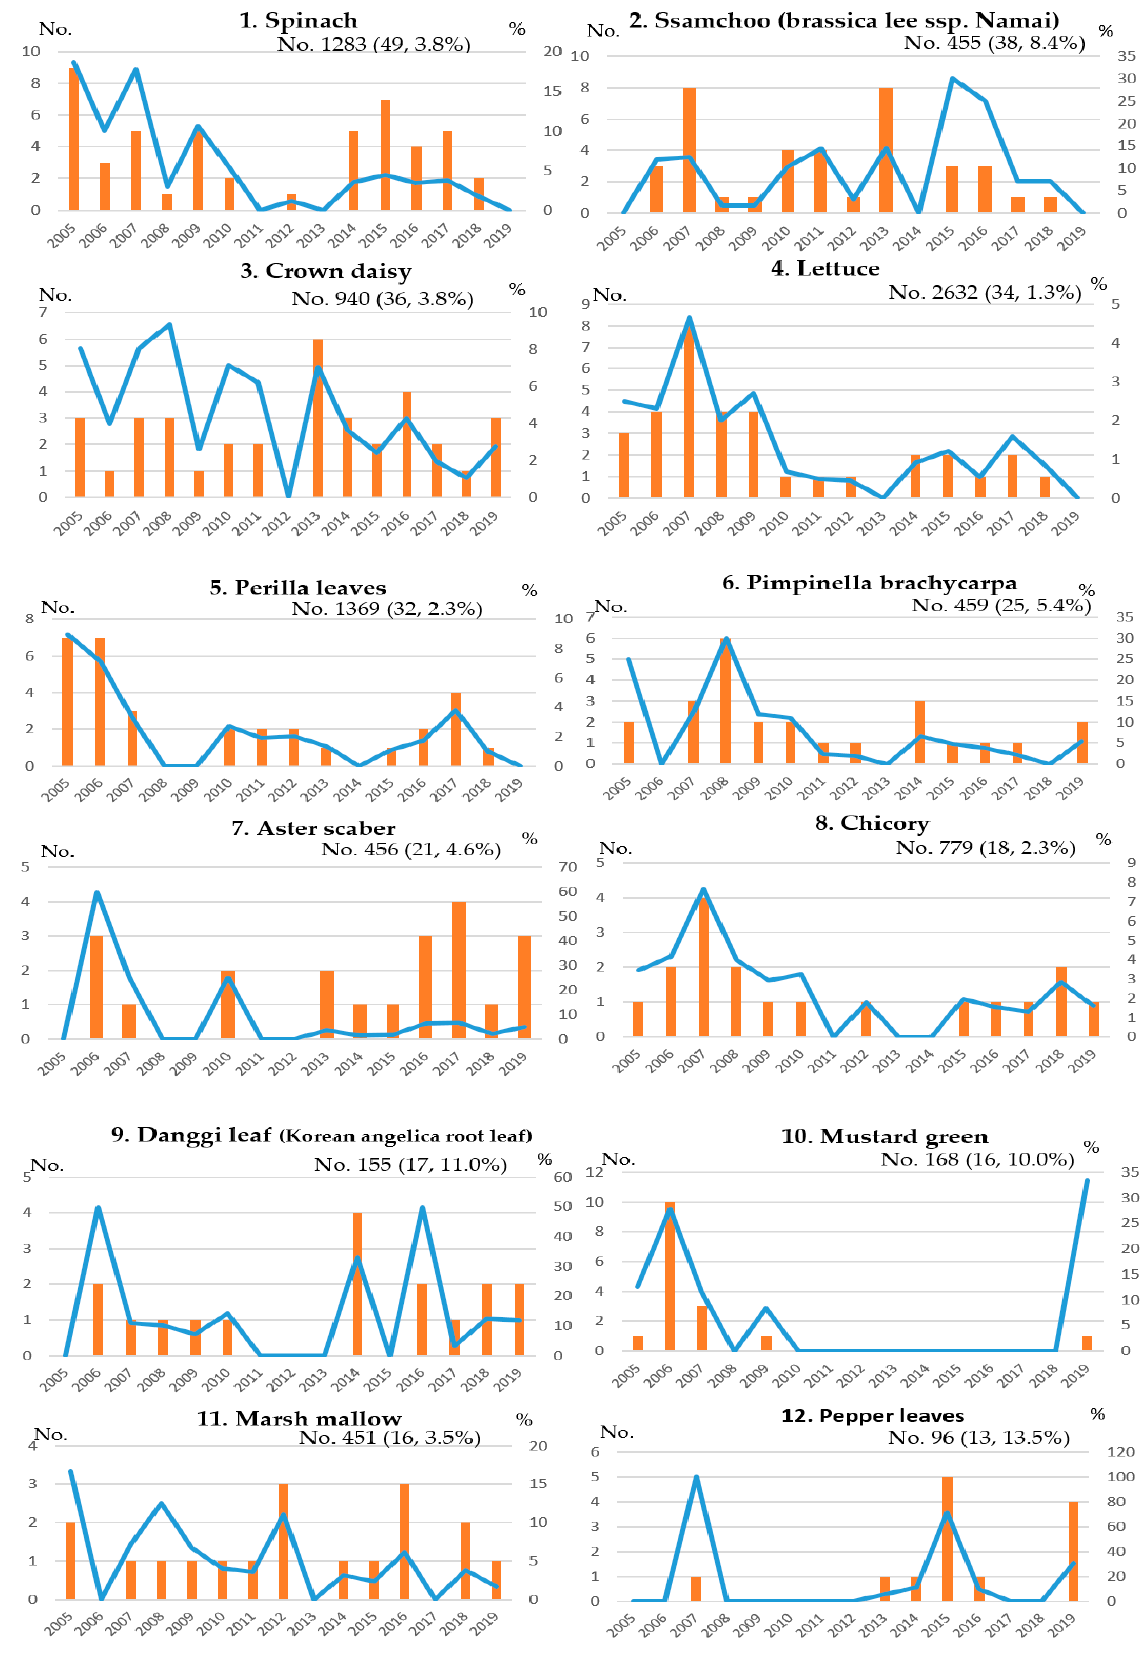
Figure 4. Annual distribution by which the MRLs are exceeded in the main leafy vegetables analyzed from 2005 to 2019 (blue lines—the nonconformity rate of samples, orange bars—the number of nonconformities of samples).